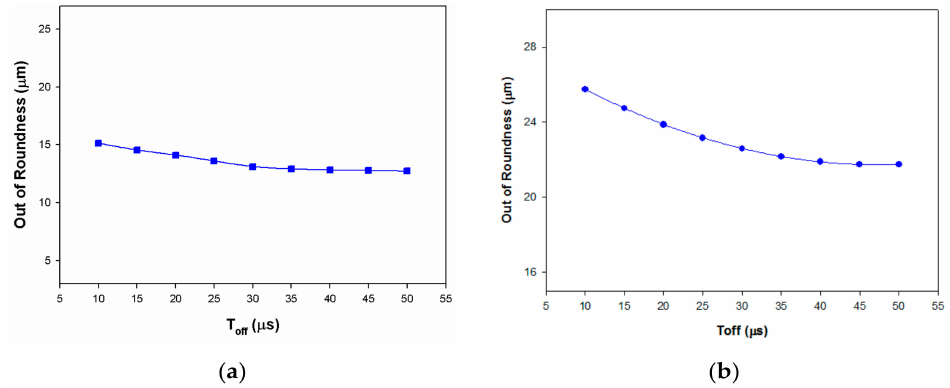
Figure 22. Main effect plots for change in OOR with Toff using ( a ) DOE model; ( b ) machine learn- ing model.